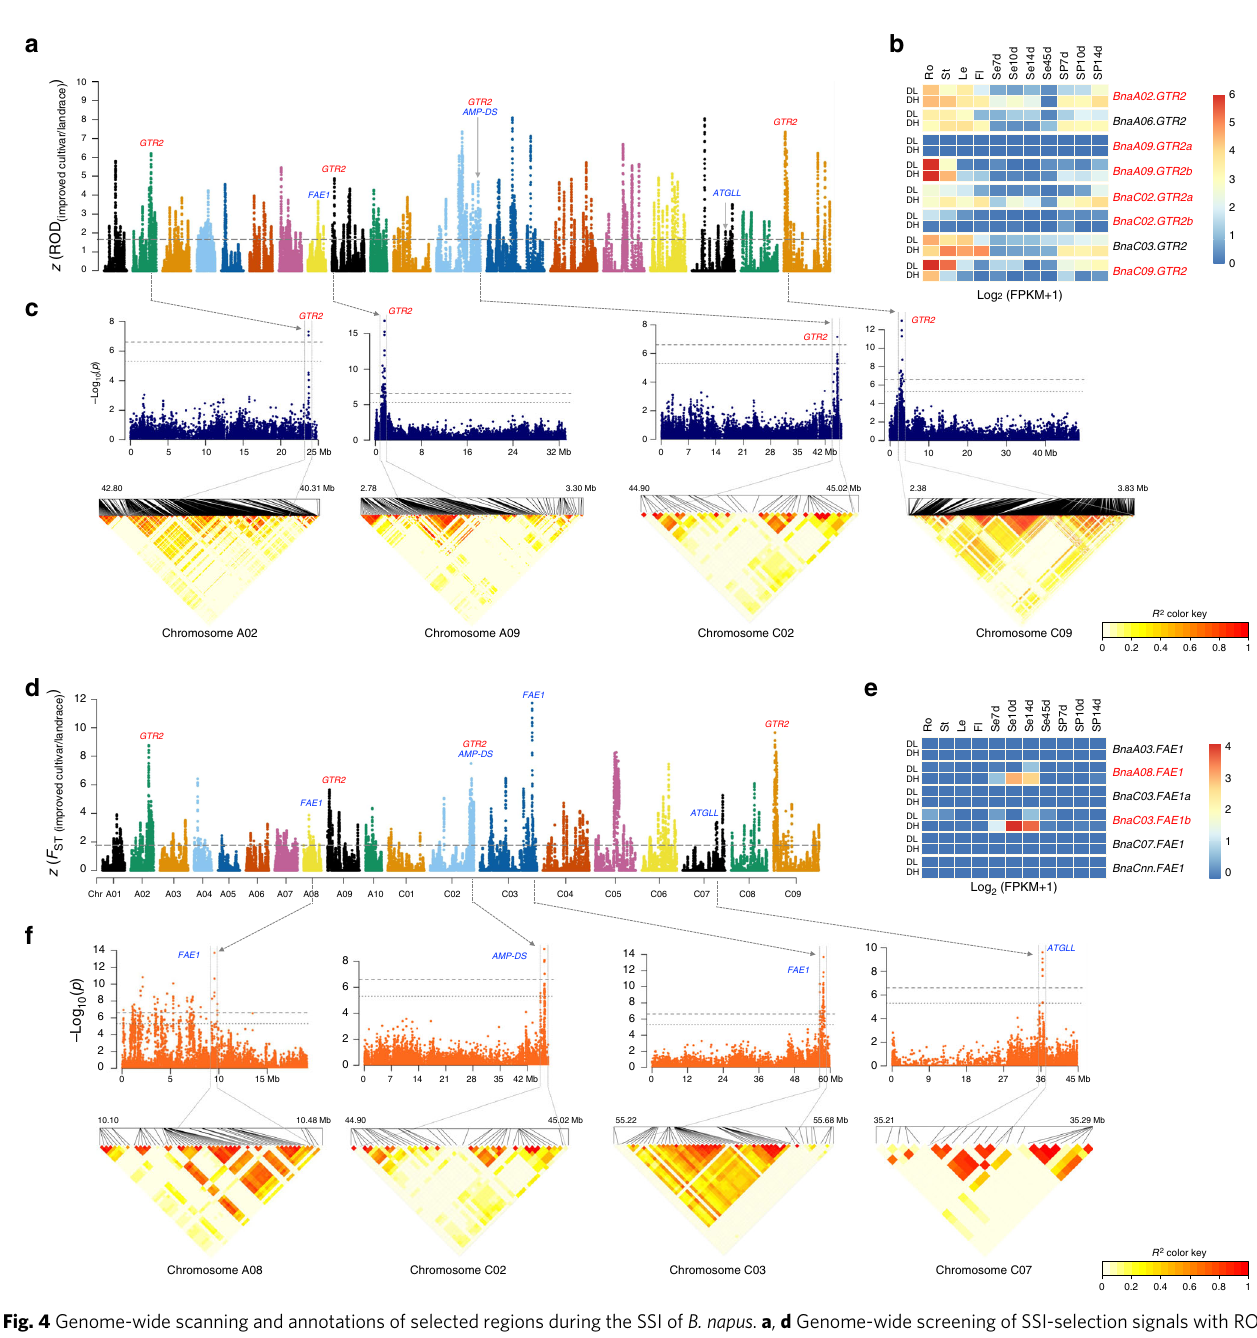
Fig. 4 Genome-wide scanning and annotations of selected regions during the SSI of B. napus . a , d Genome-wide screening of SSI-selection signals with ROD and F ST . ROD and F ST were normalized as z scores for B. napus . A 100-kb sliding window with an increment of 10 kb was used to calculate these values. Each point represents a value in a 100-kb window. Horizontal dashed lines show the signi fi cance level of α = 0.05, corresponding to z = 1.645. The glucosinolate transport genes in the selection outlier regions are labeled in red, and erucic acid biosynthesis genes are in blue. b , e Expression patterns of two GTR2 and FAE1 family members. Genes in the selection outlier regions during the SSI are in red. DH double-high accession Zhongyou821, DL double- low accession Zhongshuang11, Ro root, St stem, Le leaf, Fl fl ower, Se7d, 10d, 14d, and 45d seeds at 7, 10, 14, and 45 days after fl owering, SP7d, 10d, and 14d silique pericarp at 7, 10, and 14 days after fl owering. c , f GWAS results of total glucosinolate and erucic acid content that overlapped selection signals. Dashed horizontal lines depict the signi fi cant ( − log10( P ) = 6.61) and suggestive ( − log10( P ) = 5.31) thresholds. The lower panel shows the LD blocks of signi fi cantly associated loci in GWAS. Source data are provided as a Source Data fi le